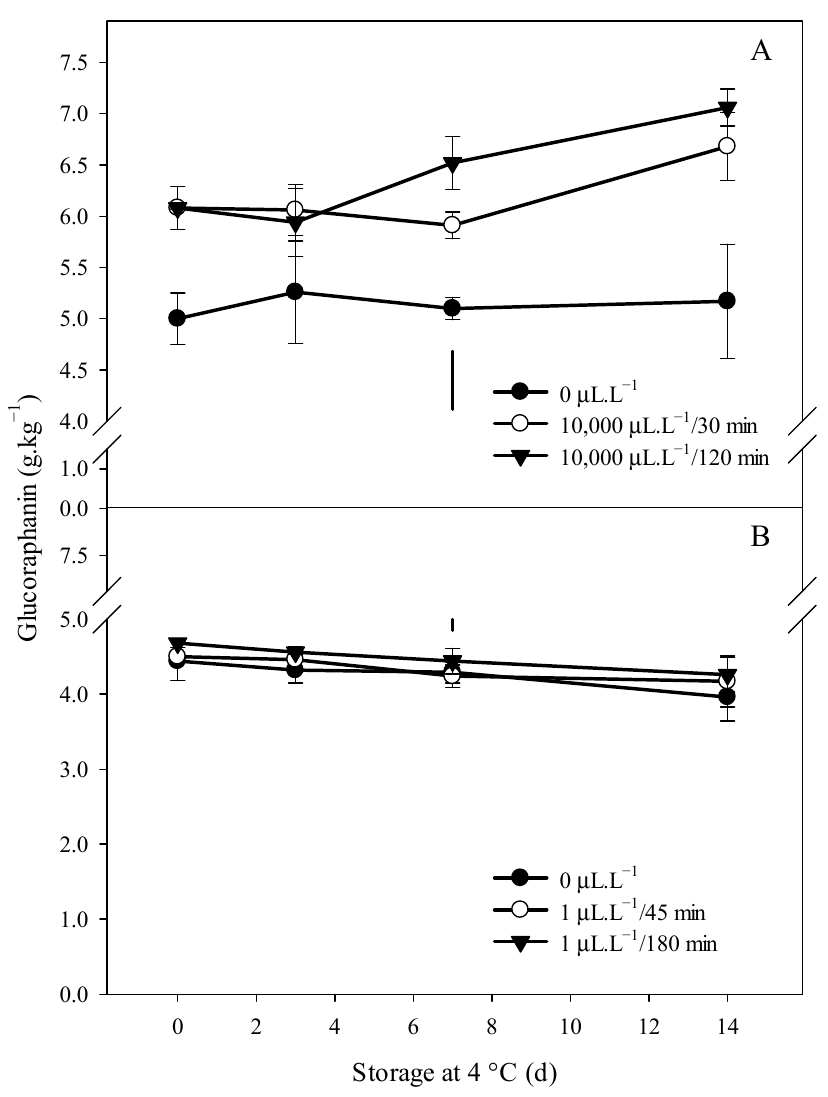
Figure 6. Total glucoraphanin contents of florets exposed to ethanol and methyl jasmonate. Broccoli florets were treated with ethanol ( A ) at three different doses: ( ● ), control; ( ○ ), 10,000 µL.L − 1 /30 min (hormetic dose); and ( ▼ ), 10,000 µL.L − 1 /120 min (high dose). Methyl jasmonate ( B ) ( ● ), control; ( ○ ), 1 µL.L − 1 /45 min (hormetic dose); and ( ▼ ), 1 µL.L − 1 /180 min (high dose). Color change ( Δ E) was observed during 21 d of storage in darkness at 4 °C. The content of glucoraphanin was monitored for 14 days of storage in darkness at 4 °C. Vertical bars represent the standard deviation (n = 4). LSD (0.05), EtOH = 0.57; LSD (0.05), MeJA = 0.29.